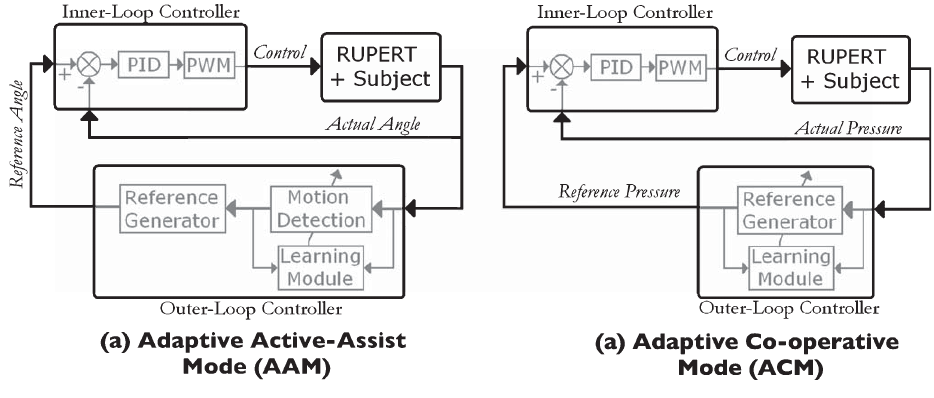
Fig. 3. Schematic of the RUPERT controllers used for the adaptive active-assist and adaptive co-operative